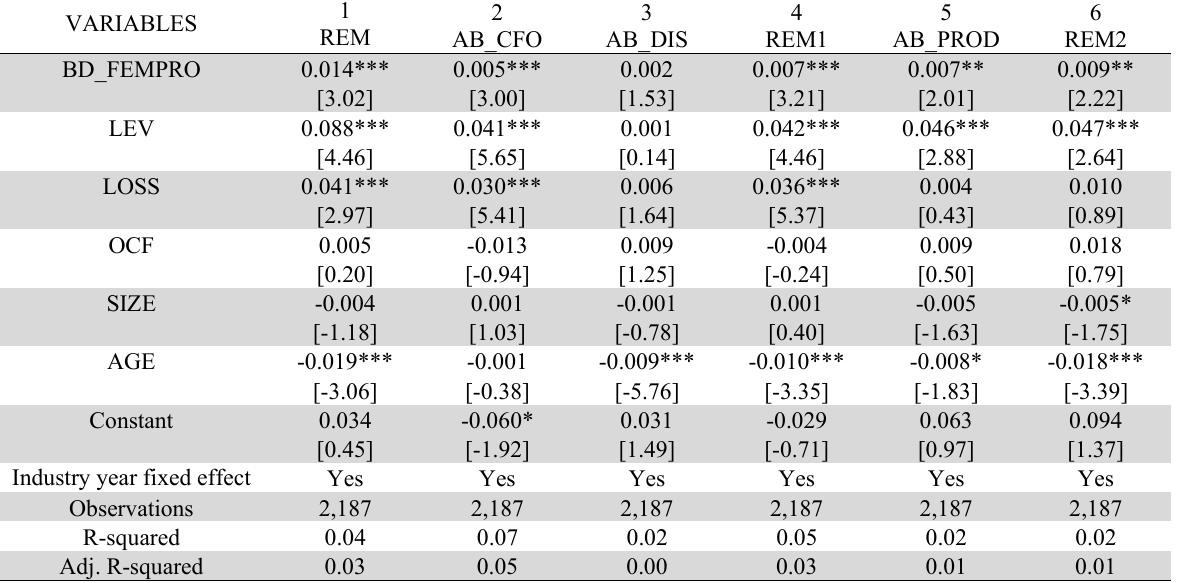
The results of the regression analysis VARIABLES